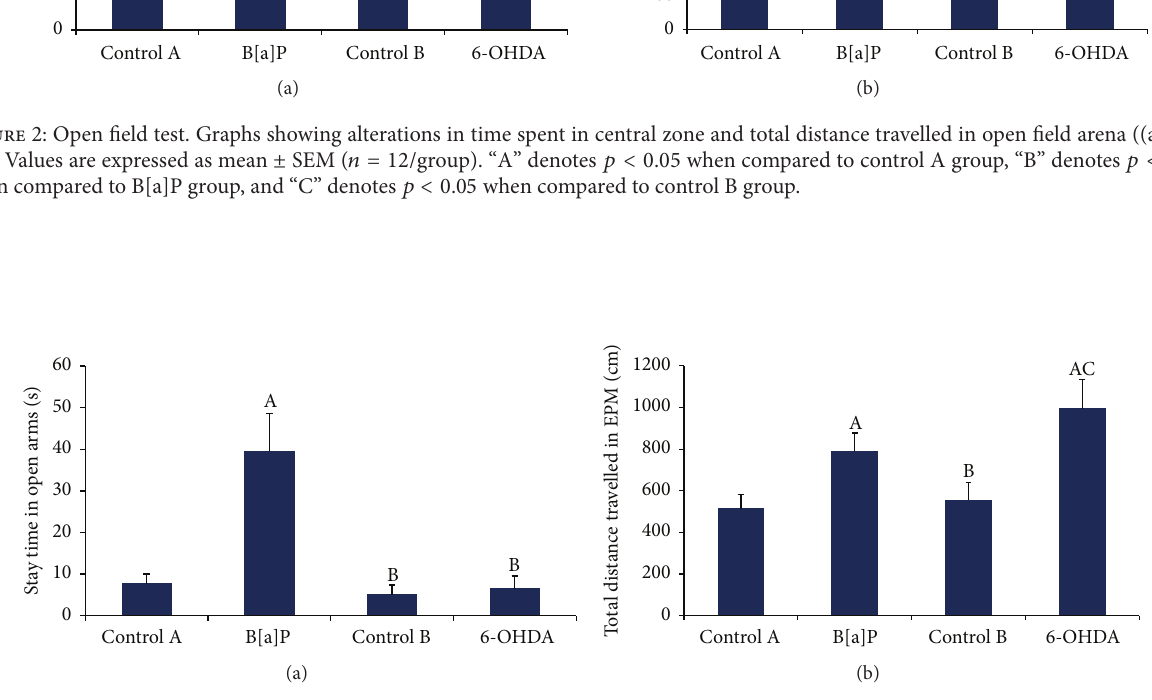
Figure 3: Elevated plus maze test. Graphs showing alterations in (a) time spent in open arm and (b) total distance travelled in elevated plus maze. Values are expressed as mean ± SEM ( 𝑛 = 12 /group). “A” denotes 𝑝 < 0.05 when compared to control A group, “B” denotes 𝑝 < 0.05 when compared to B[a]P group, and “C” denotes 𝑝 < 0.05 when compared to control B group.